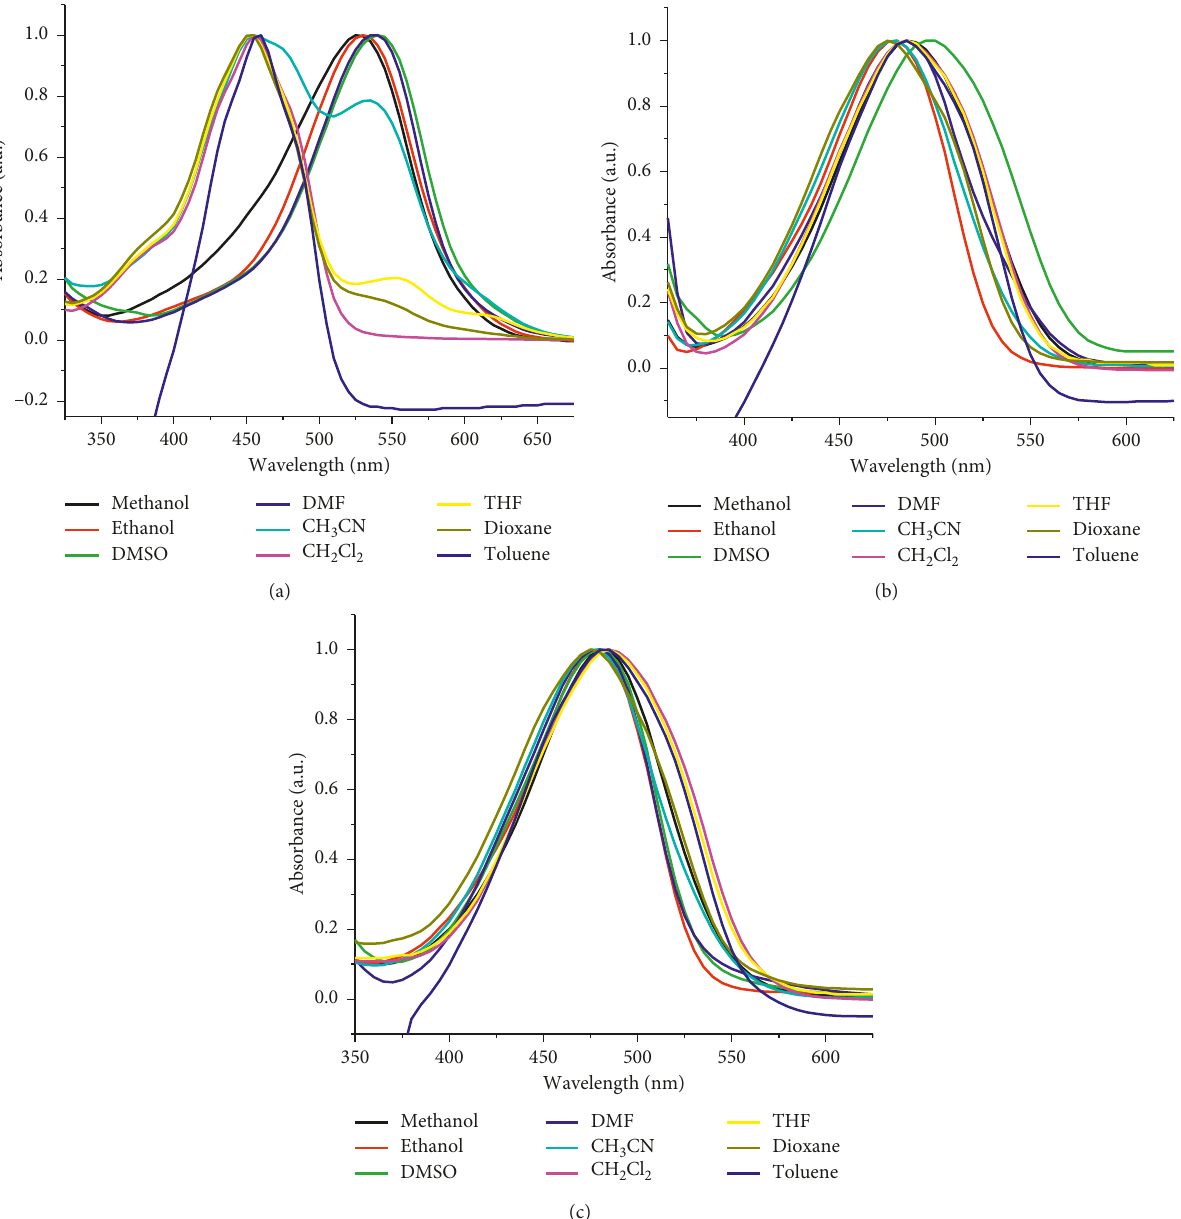
Figure 2: UV-visible absorption spectra of dyestuffs 1 (a), 2 (b), and 3 (c) in solvents of different